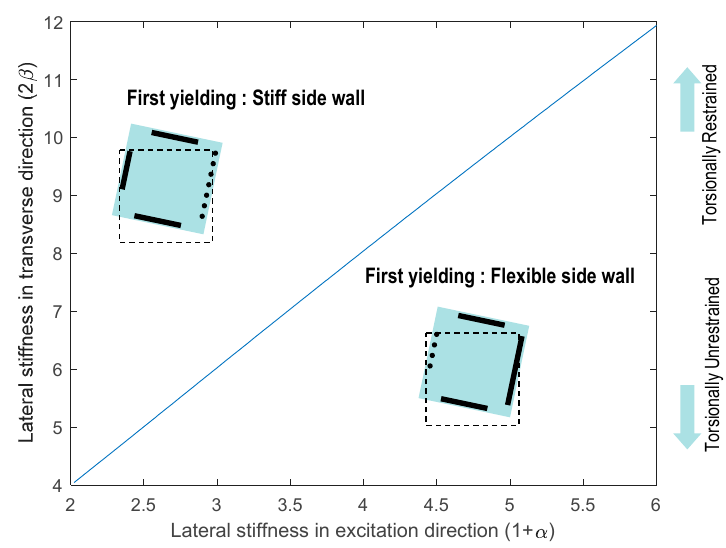
Figure 10. E ff ect of transverse wall sti ff ness on the overall yielding procedure of asymmetric Figure 10. Effect of transverse wall stiffness on the overall yielding procedure of asymmetric structures.